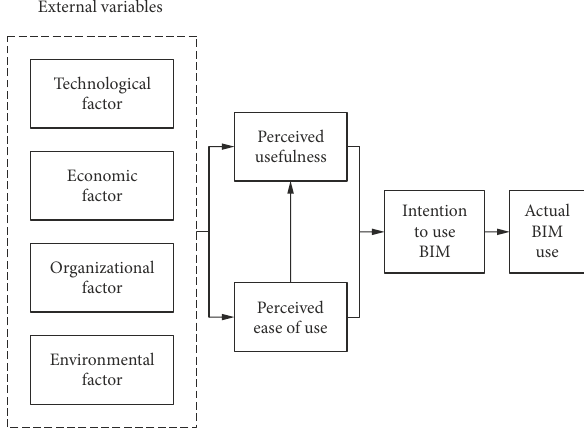
Figure 3. The integrated TAM-TOE model of BIM